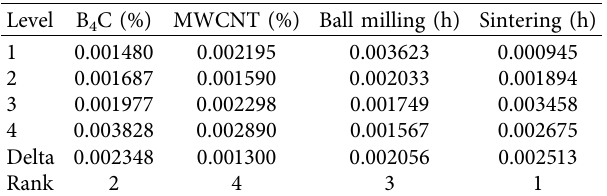
Table 10: Response table for means (corrosion).